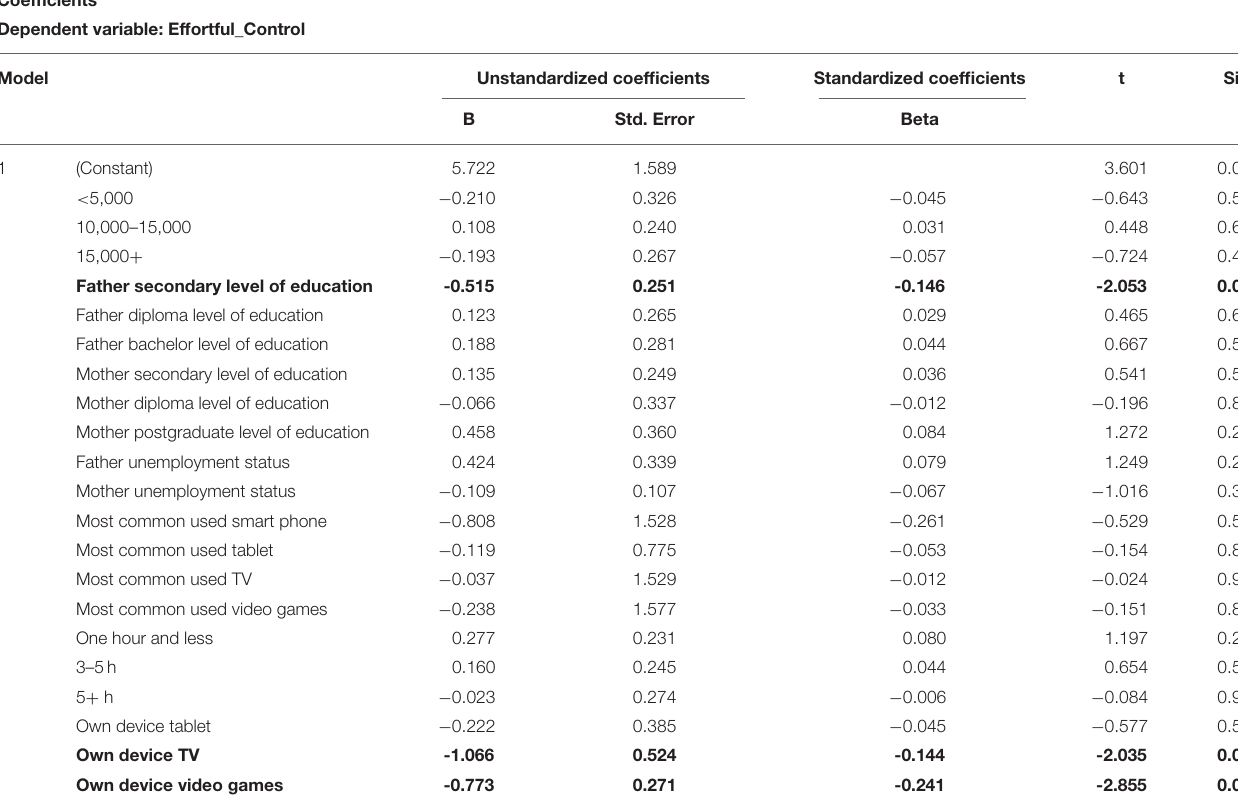
TABLE 7 | Regression coefficient table showing the strength of association between technology and demography variables and “Effortful control.” Coefficients a